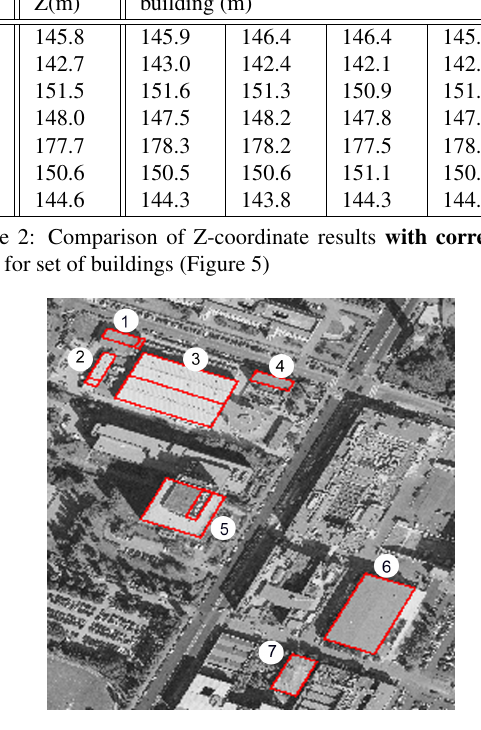
Figure 5: The numeration of buildings for Tables 1, 2. The result of image matching is marked by red